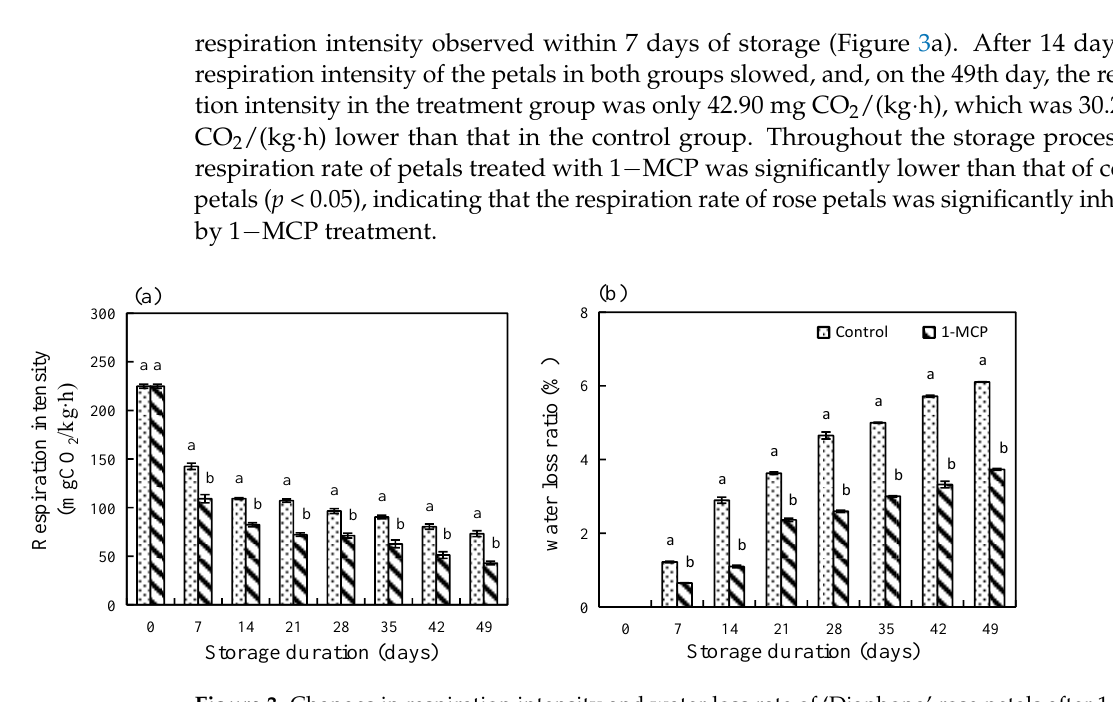
Figure 3. Changes in respiration intensity and water loss rate of ‘Dianhong’ rose petals after 1 − MCP treatment in different storage periods: ( a ) Effect of 1 − MCP on respiratory intensity; ( b ) Effect of 1 − MCP on water loss rate. Different letters on the bar chart indicate significant differences among group ( p < 0.05, n = 3).